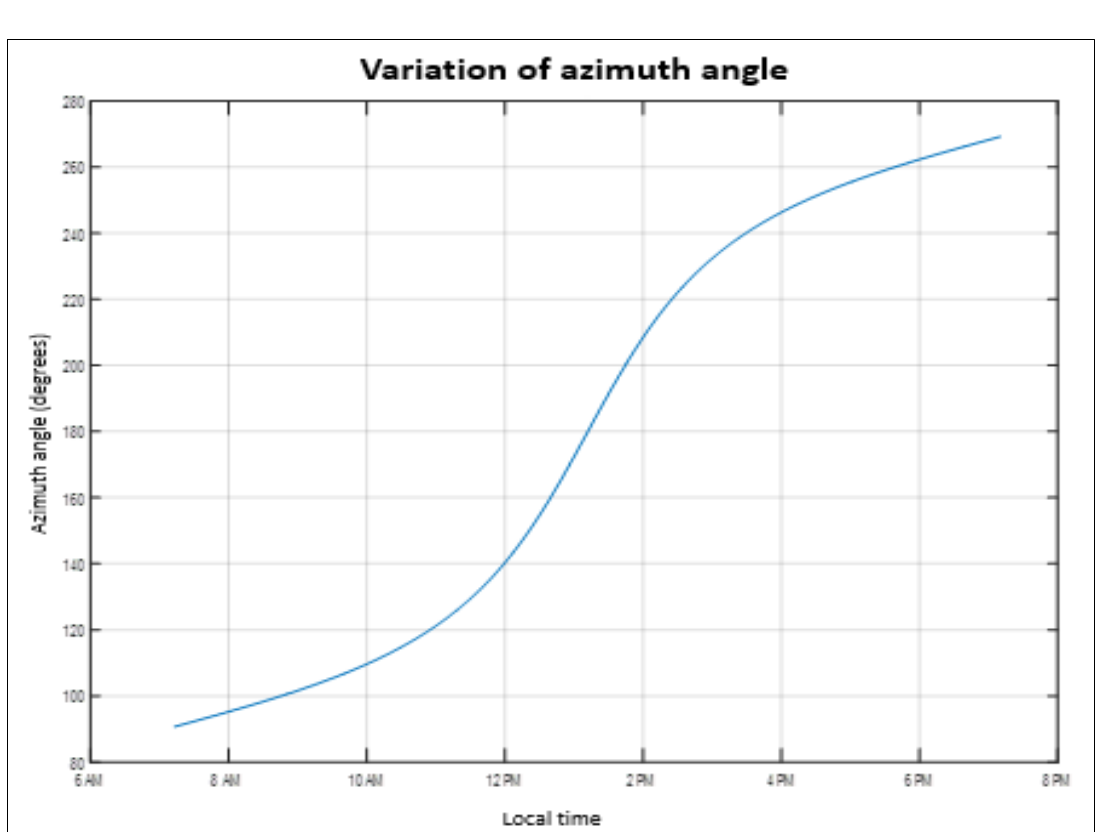
Figure 19: Behavior of the solar azimuth angle. Source: Authors,